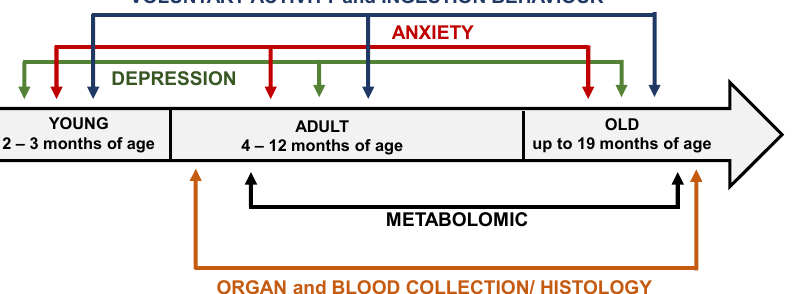
Figure 1. Experimental schedule of behavioral tests and metabolomic study performed in Sig1R KO and WT mice.